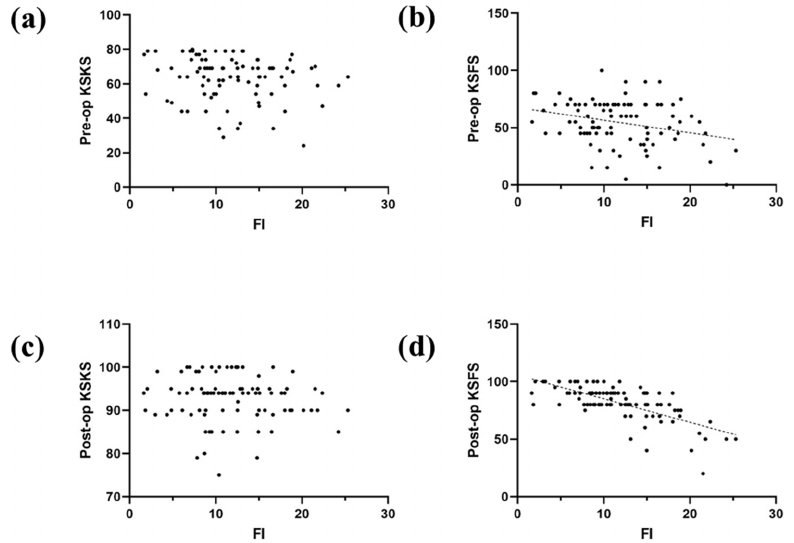
Figure 5. Scatter plots of the univariate relationship between FI ratio and ( a ) preoperative KSKS; ( b ) preoperative KSFS; ( c ) postoperative KSKS; ( d ) and postoperative KSFS. Table 2. Multivariate linear regression analysis of variables associated with postoperative KSFS.